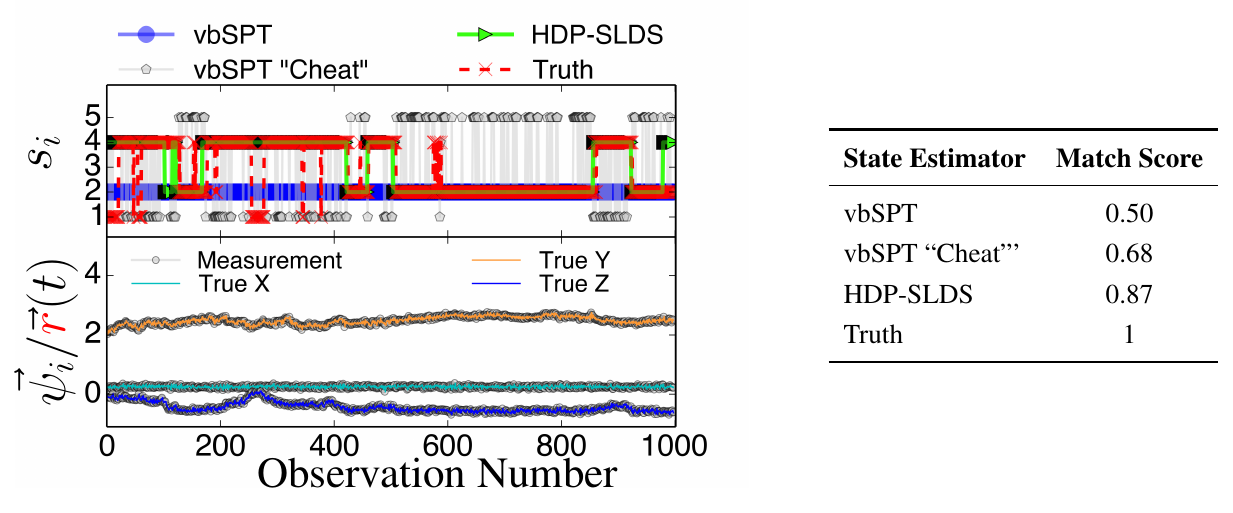
Figure 3. State estimates for three different state estimators (see text for description) along with the true state sequence (top panel), the 3D trajectory showing unobservable position and observable position (bottom panel), and the table quantifying the performance of the state estimators through the “Match Score”, which is defined as one minus the average Hamming distance for the trajectory.